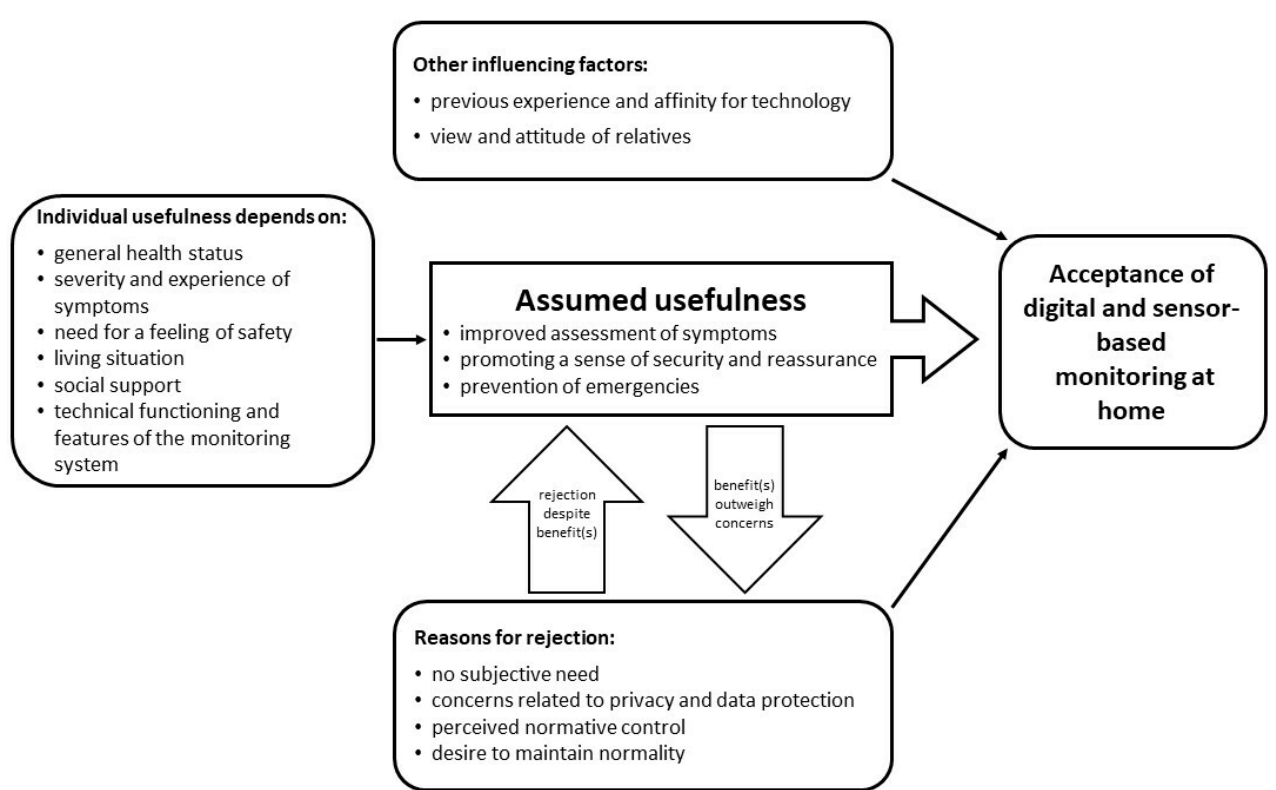
Figure 2. A preliminary model to explain the acceptance of digital and sensor-based monitoring scenarios at home among lung cancer patients.